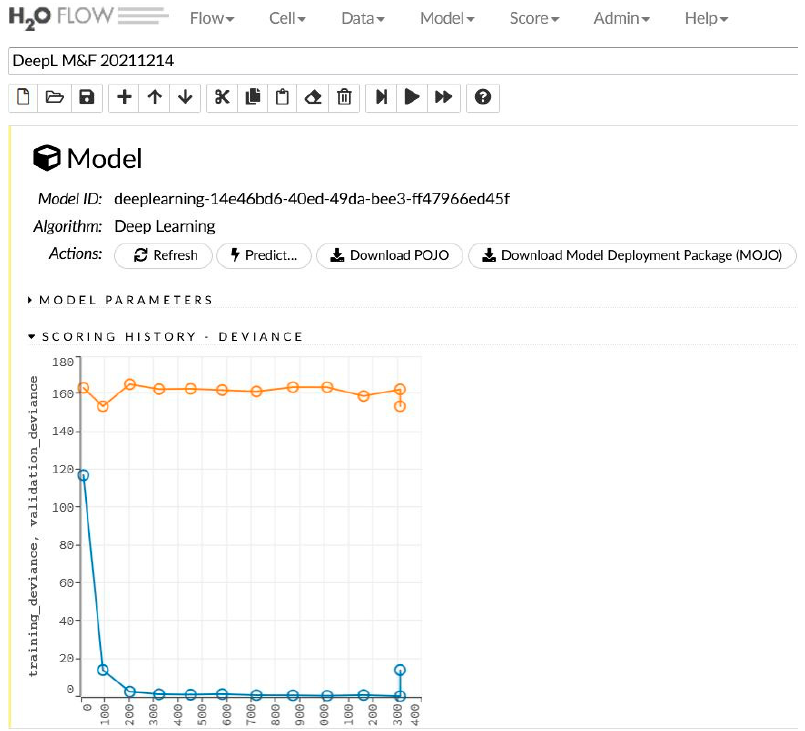
Figure 2. The generated model for women and men and the learning process. Table 2. Parameters of the generated model—age assessment for men and women.